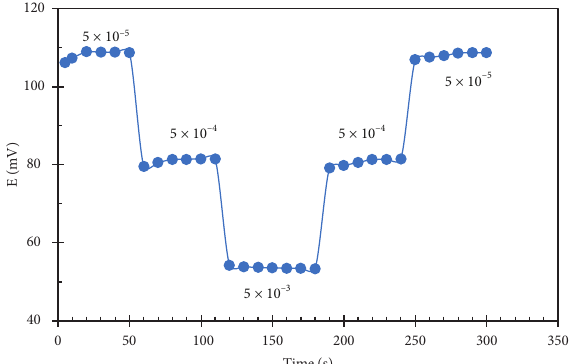
Figure 8: Dynamic response time and reversibility of MON.Cd.